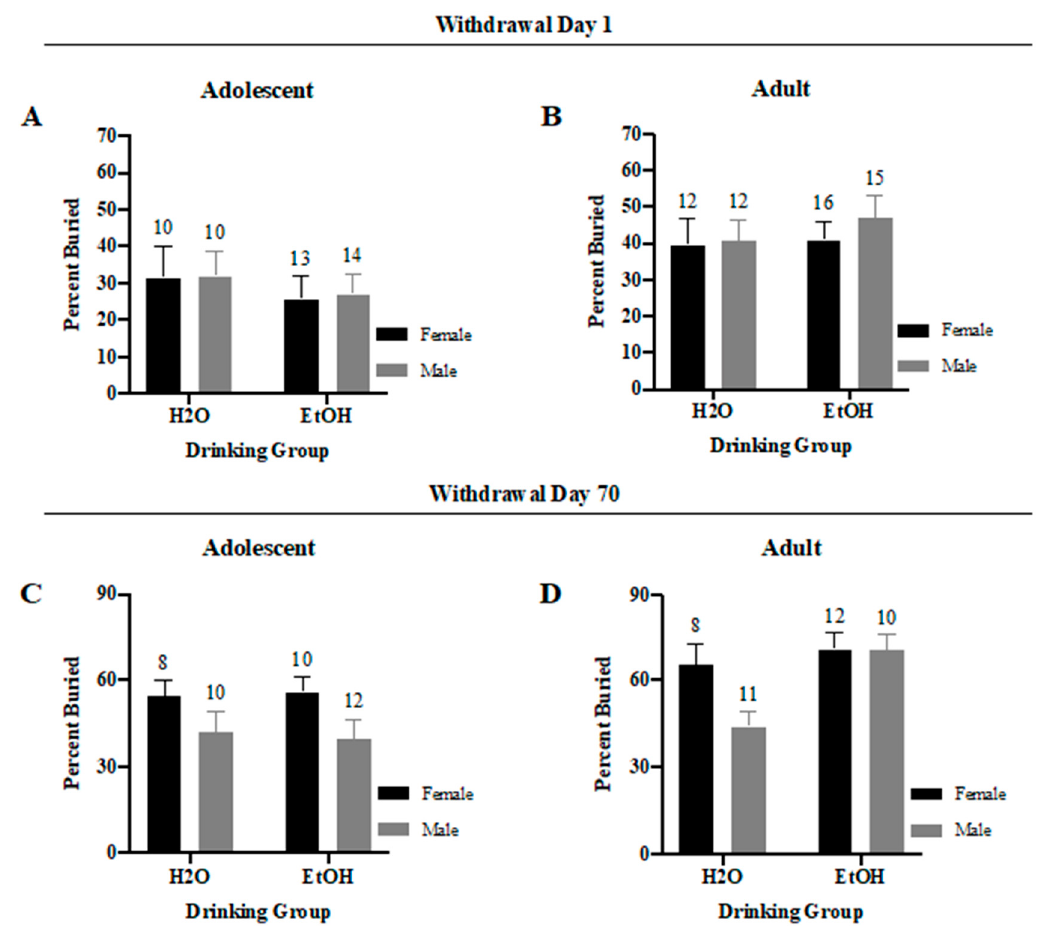
Figure 8. Summary of the results for the Sex × Drinking ANOVA observed for the percent of marbles buried. in the marble-burying test. ( A ) Depiction of the results for the adolescent-onset mice at 1-day withdrawal. ( B ) Depiction of the results observed for the adult-onset mice at 1-day withdrawal. ( C ) Depiction of the results for the adolescent-onset mice at 70-days withdrawal. ( D ) Depiction of the results for the adult-onset mice at 70-days withdrawal. The data represent the means ± SEMs for the numbers of mice indicated in each panel.